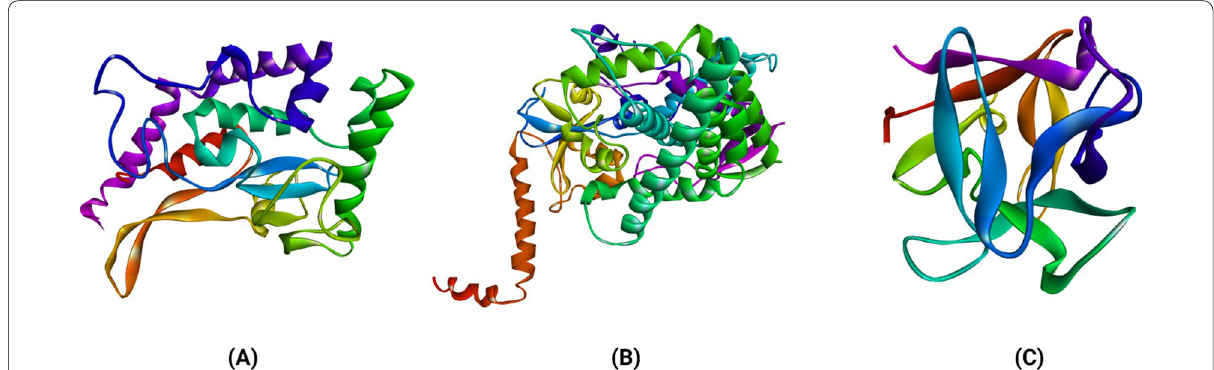
Fig. 2 Cartoon representation of structures of modelled Rhizopus delemar proteins CotH3 ( a ), Lanosterol 14 alpha-demethylase ( b ) and